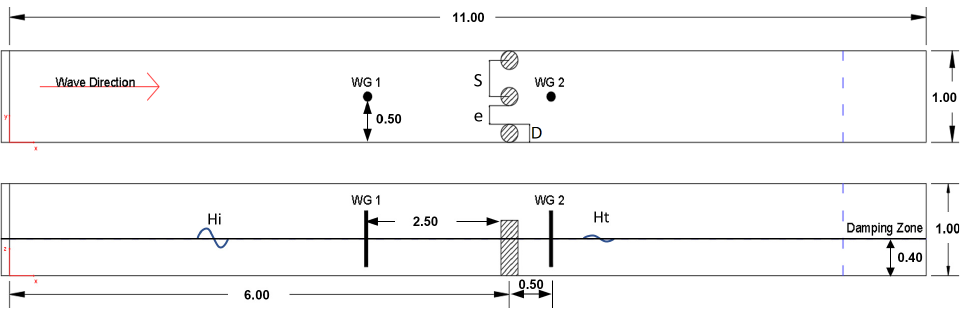
Figure 1. NWT dimension and the wave gauge placement. (Top): x–y plane, (Bottom): x–z plane. The left side is the wave generation zone, and the right side is the wave damping zone.